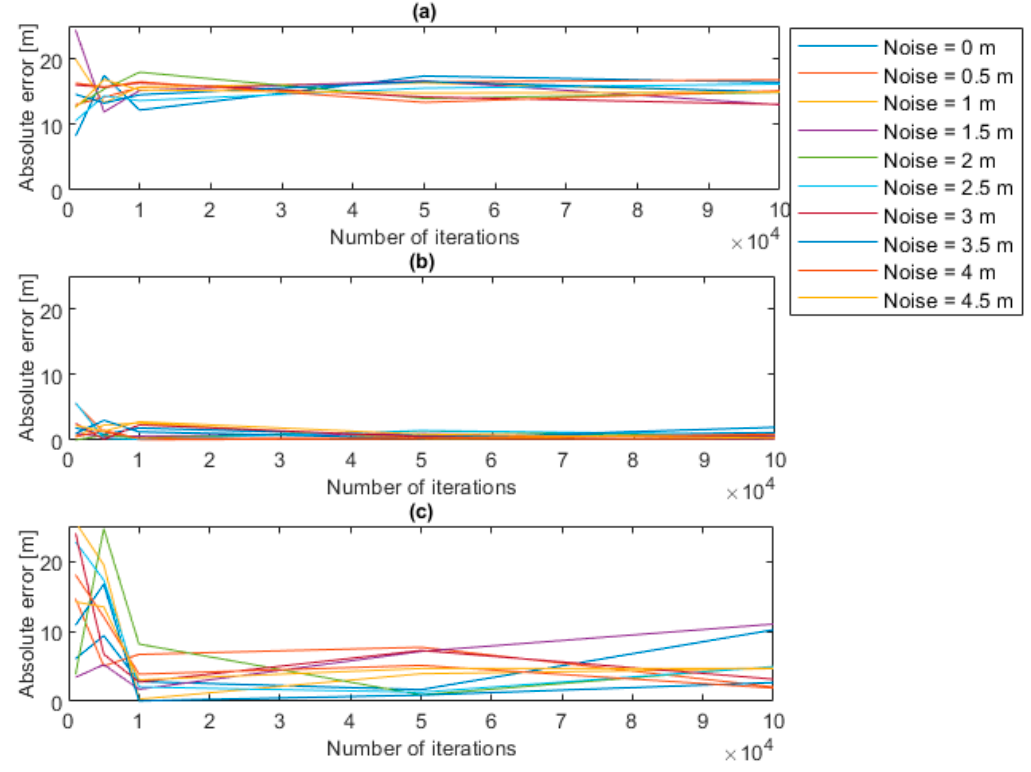
Figure 11. Error trends for different noise levels ( a ) plane depth of 0.05 m, ( b ) plane depth of 0.5 m, ( c ) plane depth of 2 m.